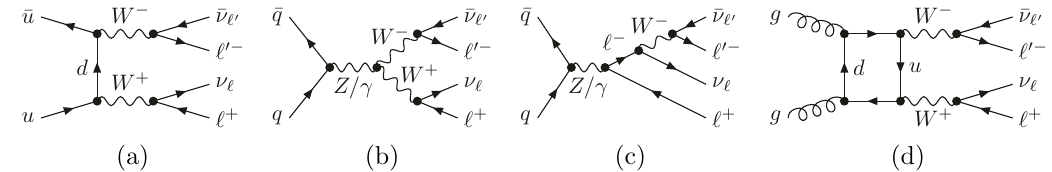
Figure 2 . Feynman diagrams for W + W − production: (a–c) sample tree-level diagrams in the quark-annihilation channel contributing at LO; (d) sample loop-induced diagram in the gluon fusion channel contributing at the